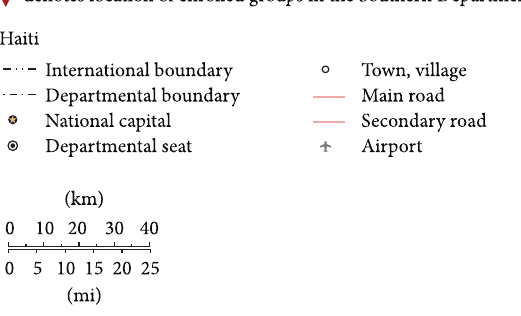
Figure 2: Geographic distribution of groups enrolled in the Group of 6 program throughout Haiti’s Southern Department. Source: this map was adapted from United Nations Map No. 3855 Rev. 4: United Nations Department of Field Support Cartographic Section; 2008 [cited 2014 May 31]. Available from http://www.un.org/depts/Cartographic/map/profile/haiti.pdf